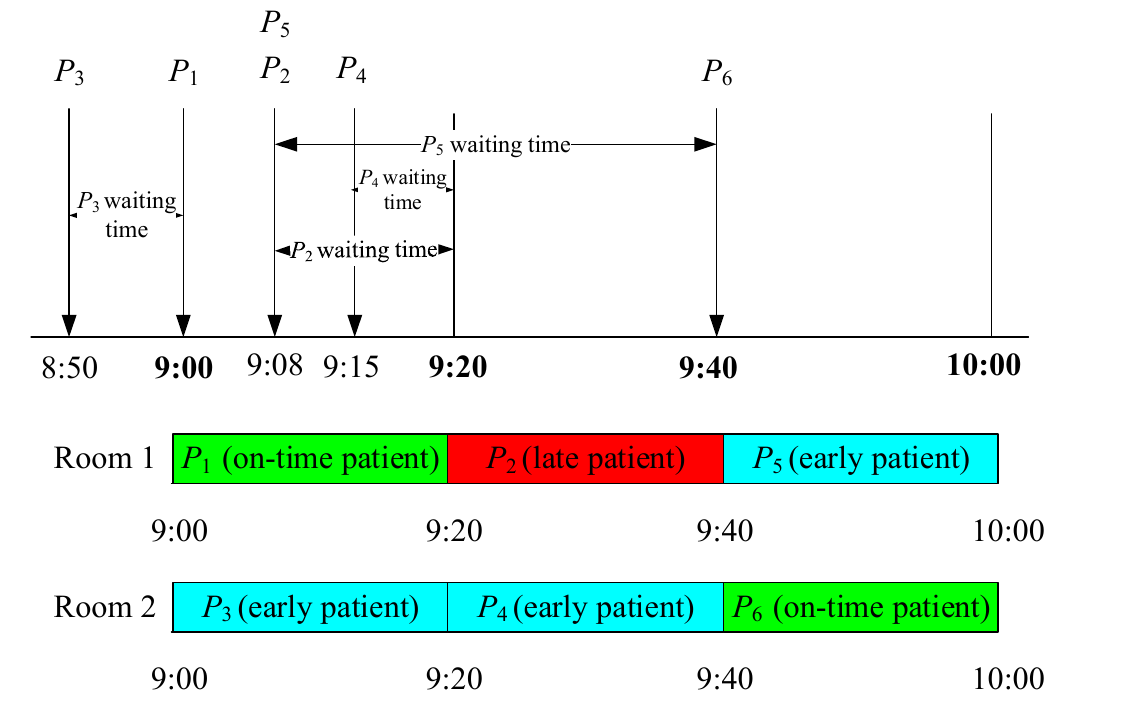
Figure 2. Examples of the preempt policy with constant service time. Table 10. Preempt policy with constant service time.